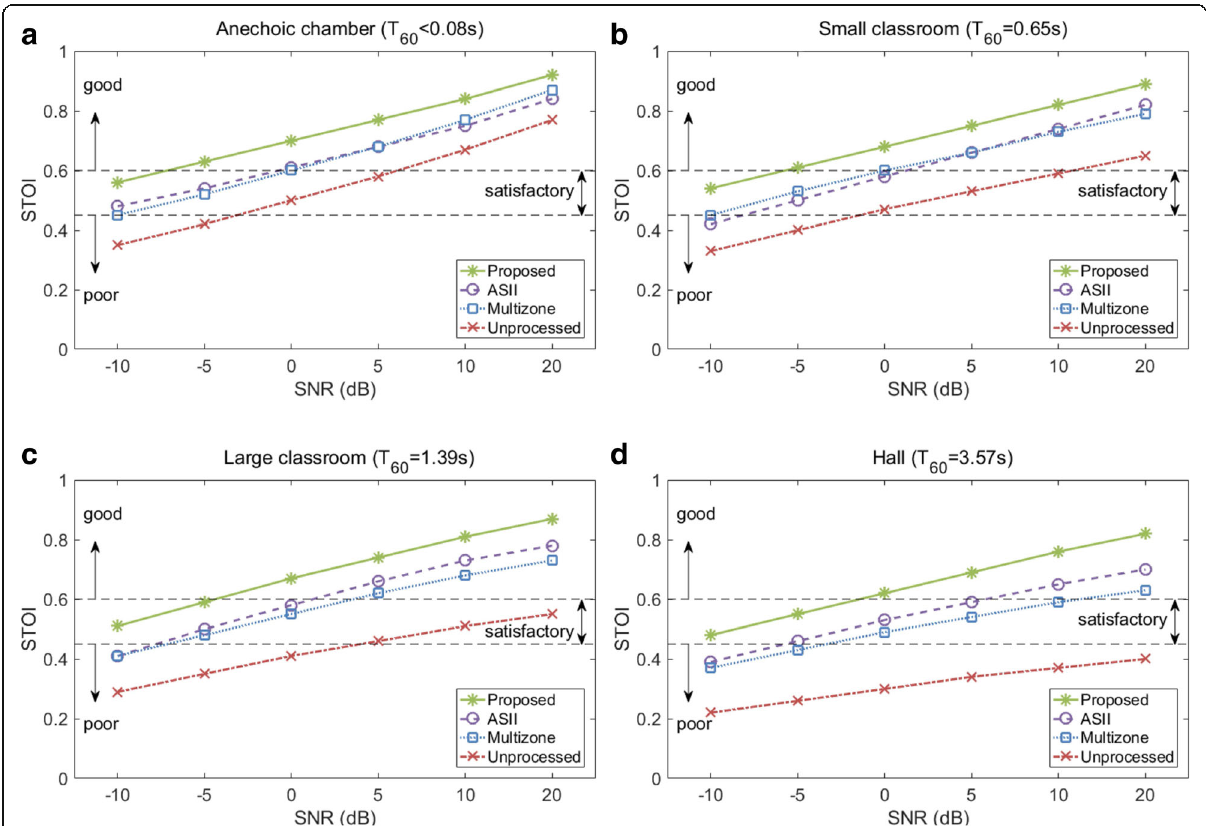
Fig. 6 Comparison results of STOI prediction under different test conditions. a anechoic chamber ( T 60 = 0.08s), b small classroom ( T 60 = 0.65s), c large classroom ( T